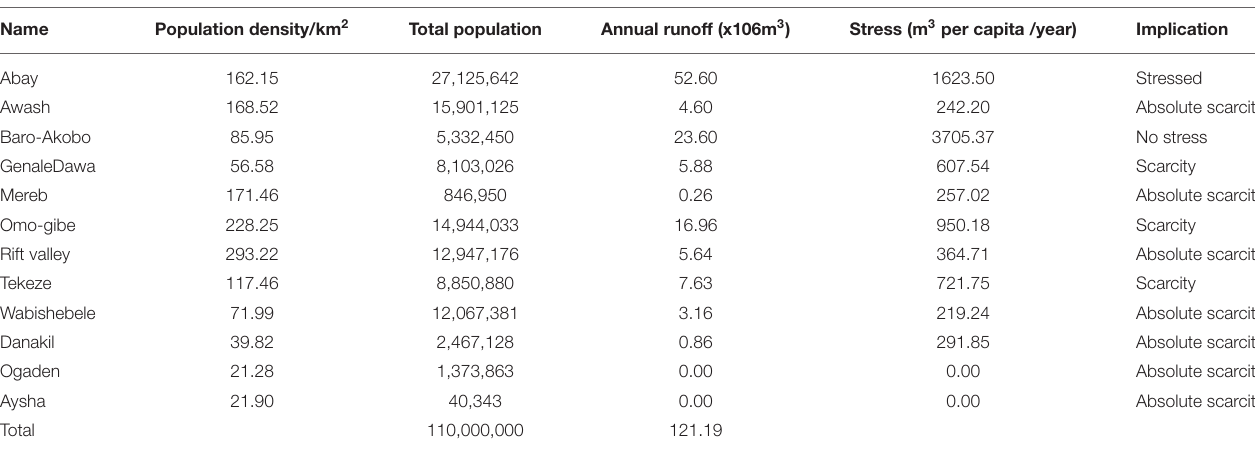
TABLE 6 | A level of water stress at major river basins of